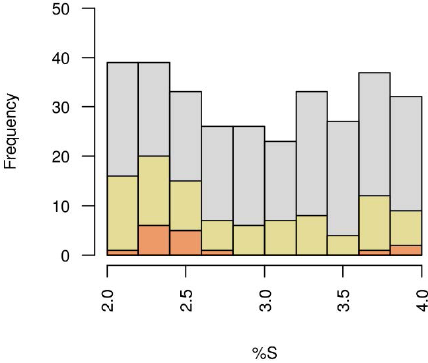
Figure 5. LGM change in global sea ice area